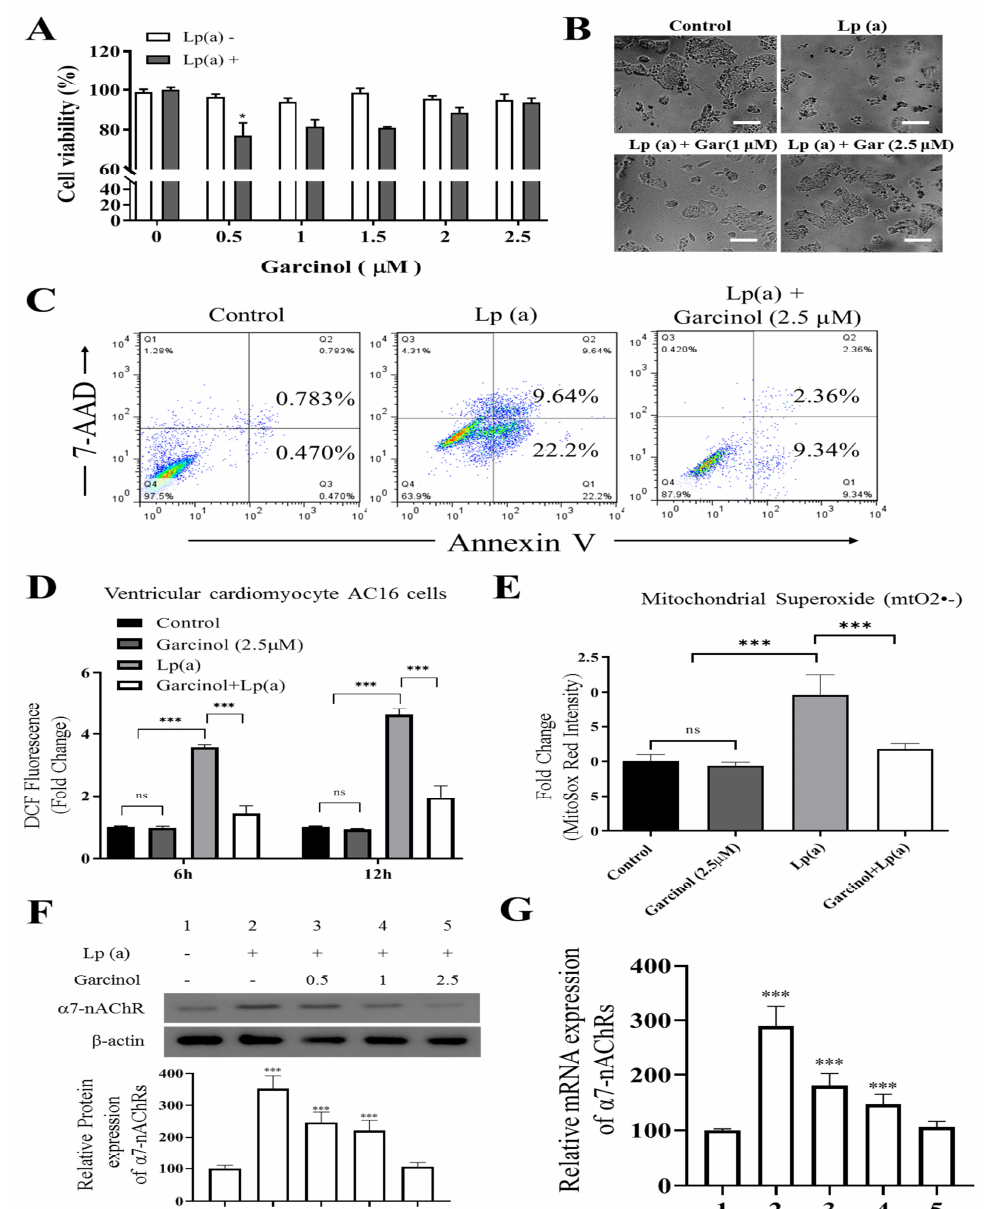
Figure 2. Garcinol reduced Lp(a)-induced reactive oxygen species (ROS) production and cytotoxicity in Ventricular Figure 2 cardiomyocyte AC16 cells. ( A ) Different concentrations of garcinol did not affect the viability of cardiomyocytes, but garcinol inhibited the cell cytotoxicity induced by Lp(a) in concentration-dependent manners. ( B ) Reduced alterations in morphology of Lp(a)-treated cardiomyocytes with simultaneous garcinol treatment. scale bars = 20 µ m. ( C ) Garcinol inhibited Lp(a)-induced apoptosis in AC16 cell. Annexin V-PE/7-AAD dual staining was to detect apoptosis. ( D ) Garcinol suppressed Lp(a)-induced ROS production in human ventricular cardiomyocyte AC16 cells. AC16 were exposed to Lp(a) (1 µ M), garcinol (2.5 µ M) or Lp(a) (1 µ M) with 6 h pretreatment with garcinol (2.5 µ M). Six and 24 h after stimulation, AC16 cells were then incubated with DCFH-DA (20, 70-dichlorodihydrofluorescein diacetate), and the level of ROS production was detected by FACStar flow cytometer. ( E ) Ventricular cardiomyocyte AC16 cells were pretreated with Lp(a) (1 µ M), garcinol (2.5 µ M) or Lp(a) (1 µ M) and mitochondrial superoxide mtO2 •− production-specific dye, MitoSOX TM Red, before flow exposure. ( F ) The protein and ( G ) mRNA expression levels of α 7-nAChR were significantly decreased by garcinol in a dose-dependent manner. * p < 0.05, ** p < 0.01, *** p <